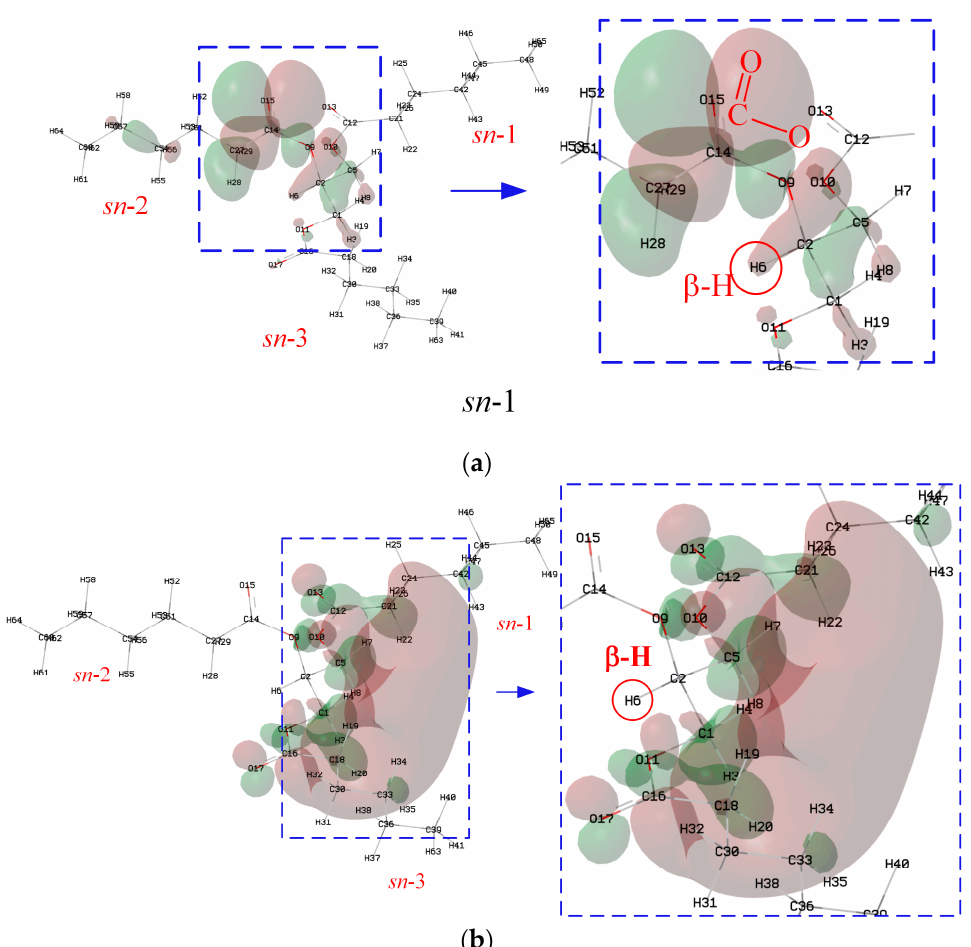
Figure 5. Isosurface of the HOMO and LUMO of N-CoCoCo: ( a ) HOMO; ( b )